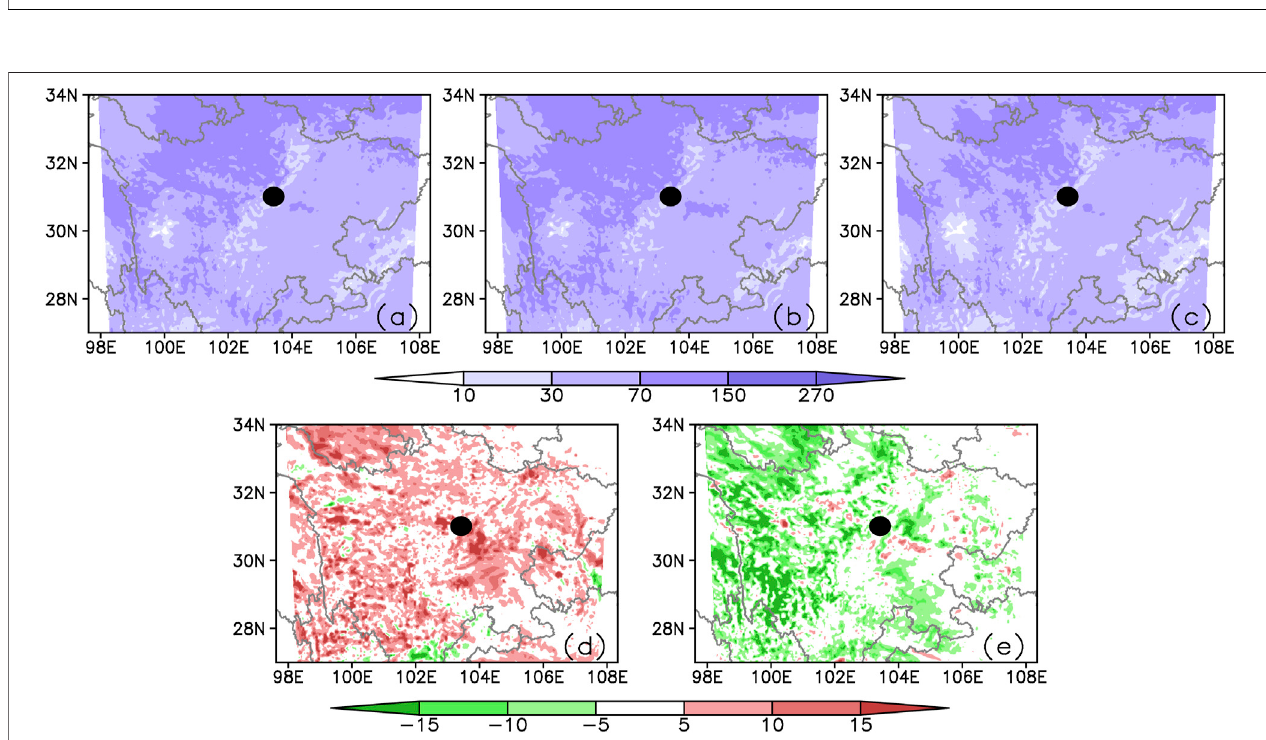
FIGURE11| The48-haveragesurfacesensibleheat fl ux(units:W m − 2 )from00:00UTConMay12to00:00UTConMay14,2008for (A) theCTLexperiment, (B) the TMP+1.5 experiment, (C) the TMP − 1.5 experiment, (D) the difference between the CTL and TMP+1.5 experiments and (E) the difference between the CTL and TMP − 1.5 experiments. The black dot represents the epicenter of the earthquake.